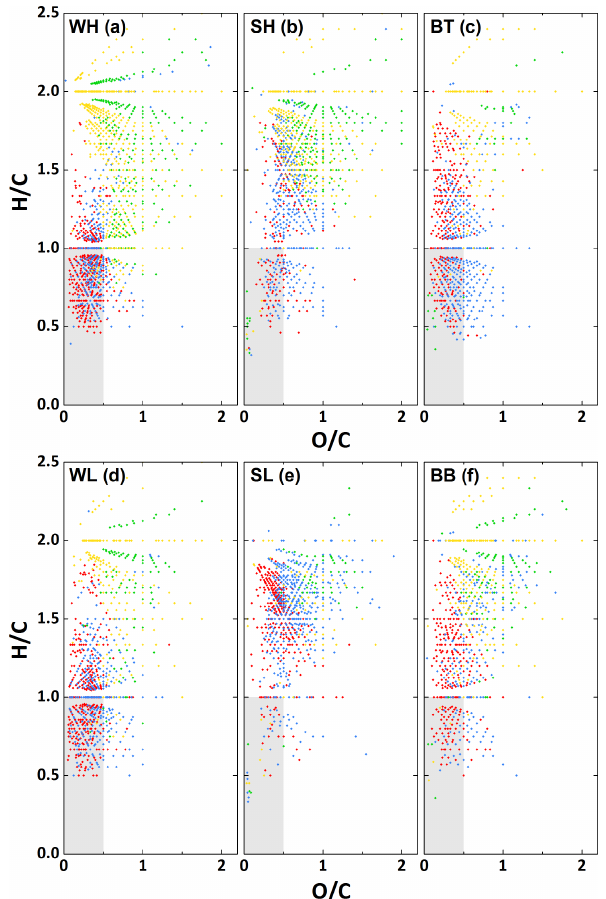
Figure 4. Van Krevelen plot for the WH, WL, SH, SL, BT and BB sample sets. The colours denote the CHO (red), CHON (blue), CHOS (yellow) and CHONS (green) formulae detected for each sample set. The aromatic region is shaded in grey.